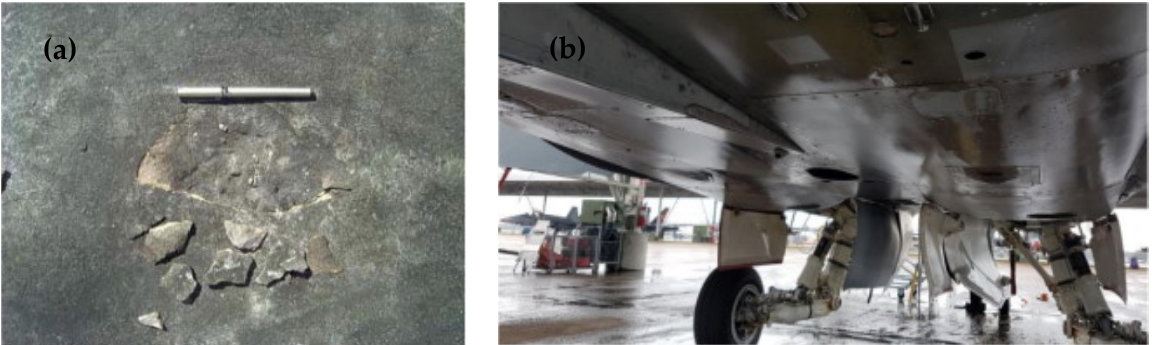
Figure 3. ( a ) Scaling at the top layer of the military airbase concrete and ( b ) Underbelly of an F/A-18 with the APU in the centre. Reprinted/adapted with permission from [107]. 2018. Shill.